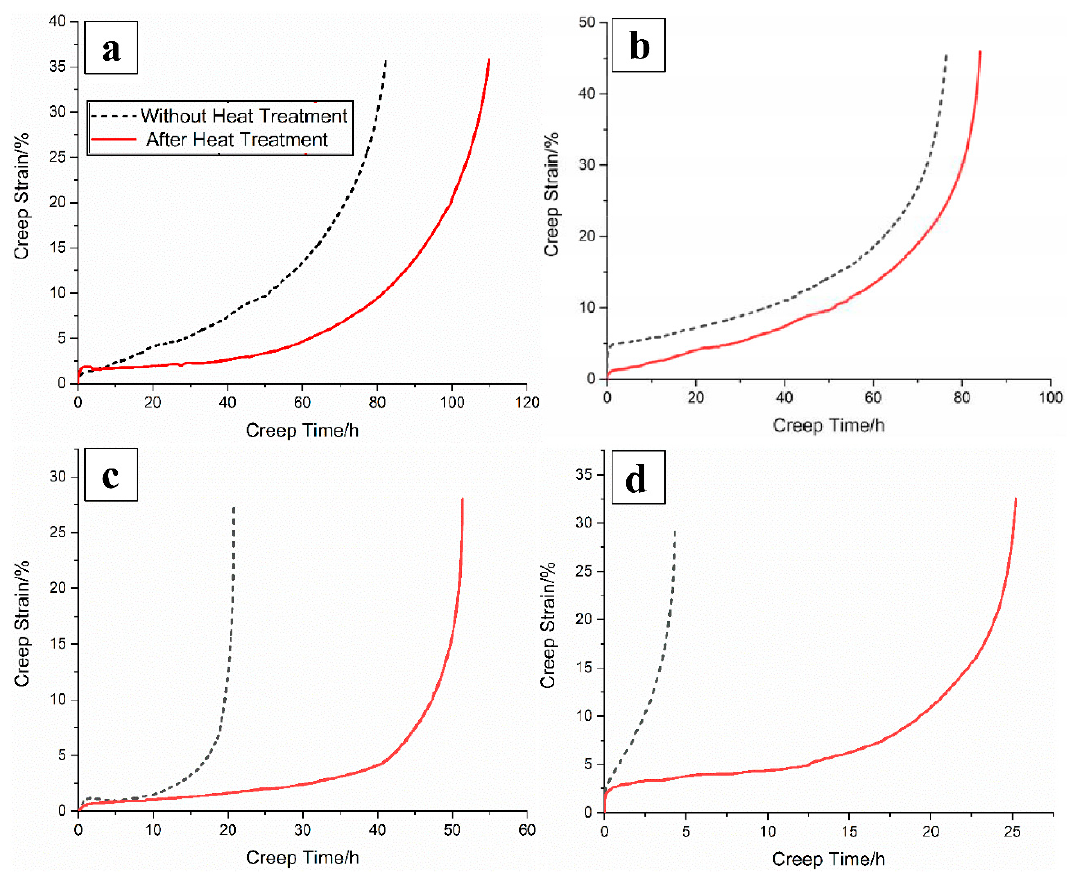
Figure 9. The secondary creep test curves of the specimens whose creep interruption time is ( a ) 20 h, ( b ) 40 h, ( c ) 70 h, and ( d ) 100 h without restoration heat treatment and after restoration heat treatment.